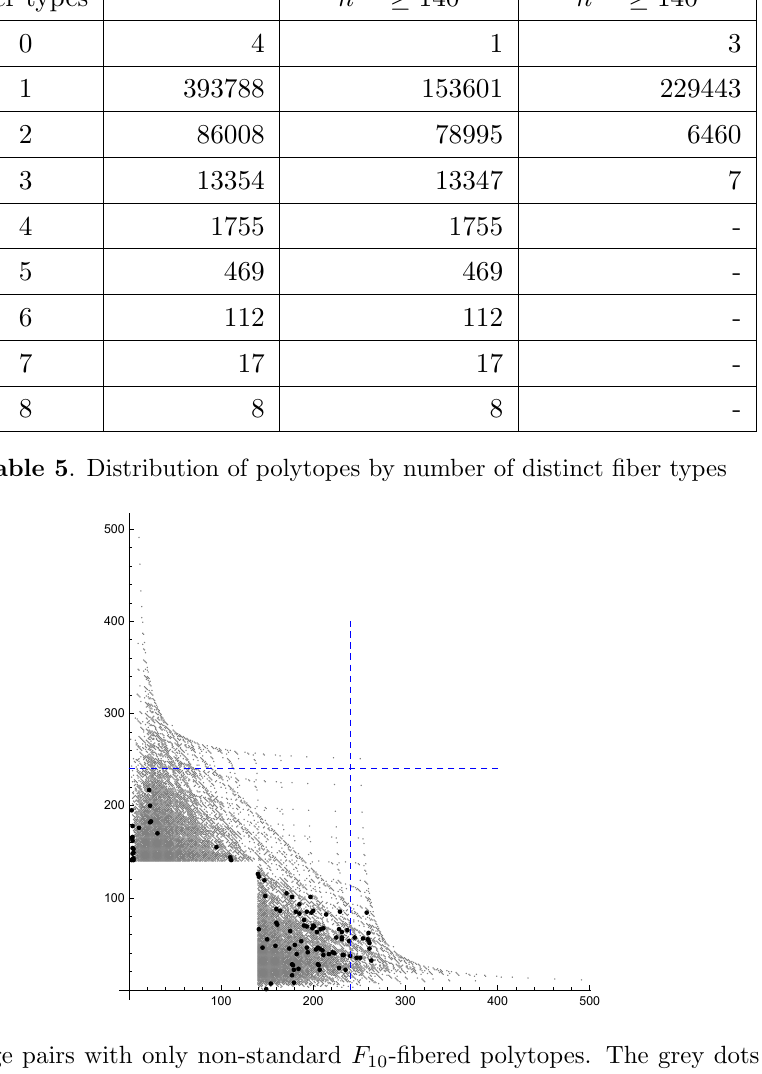
Figure 4 . Hodge pairs with only non-standard F 10 -(cid:12)bered polytopes. The grey dots correspond to all Hodge pairs with F 10 (cid:12)bers. The black dots correspond to Hodge pairs with only non- standard F 10 -(cid:12)bered polytopes. The vertical and horizontal dashed line correspond to h 1 ; 1 = 240 and h 2 ; 1 = 240,